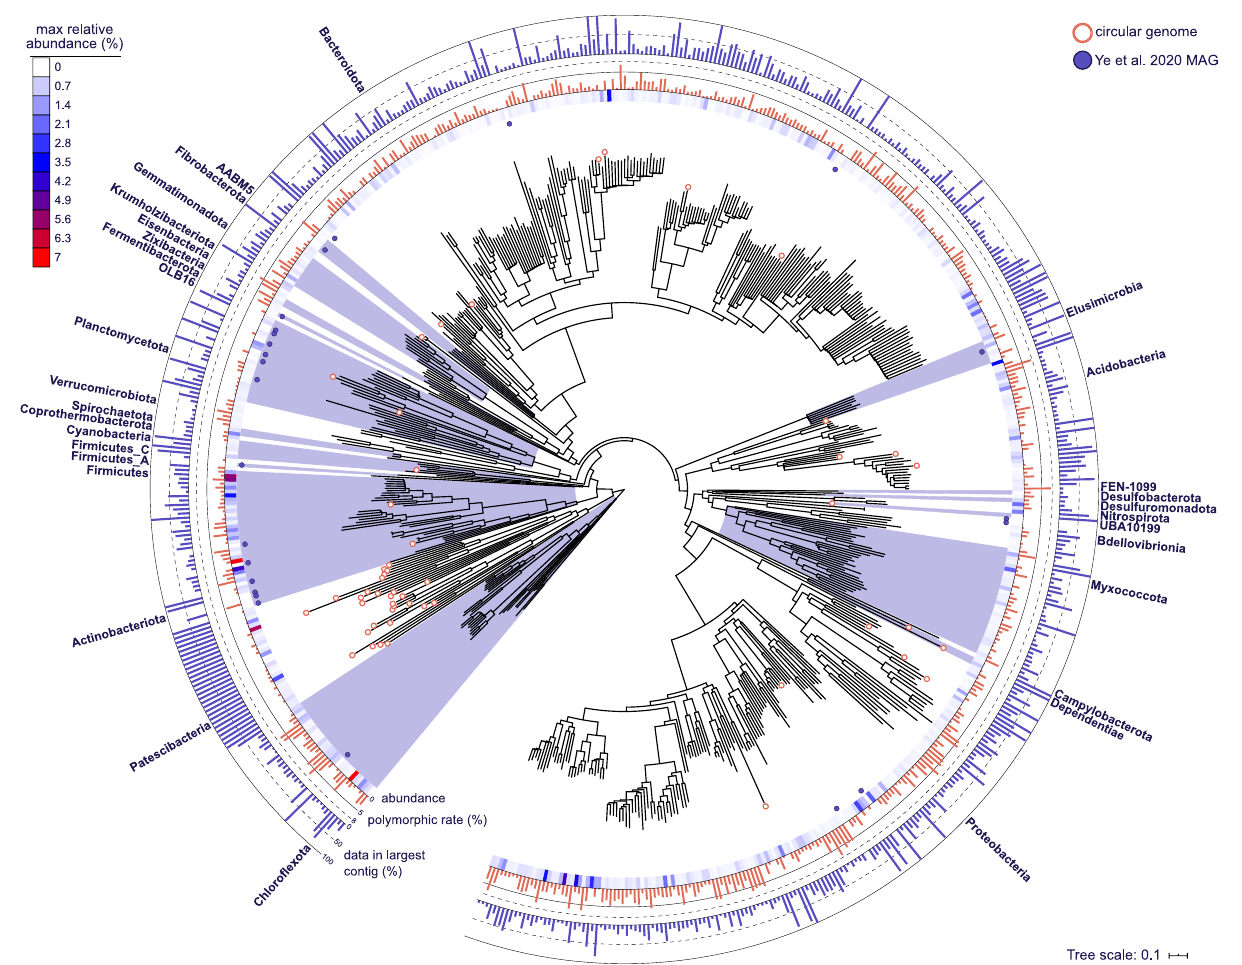
Fig. 2 Phylogenetic bacterial genome tree showing the diversity, maximum abundance, and contiguity of recovered species. The tree is based on the concatenated alignment of 120 single-copy marker gene proteins using GTDB-Tk. The 578 HQ bacterial species representatives are shown, with phyla labeled. Circular genomes are indicated at the tips using a white fi lled circle. HQ MAGs from Ye et al. 9 are indicated by the purple circles. The maximum relative abundance of the MAG across the 69 WWTP metagenomes is indicated by the heatmap. Polymorphic rate is indicated by the red bar chart and percentage of data incorporated in the longest contig within the MAG is indicated in the blue bar chart. Additional information on the MAGs is presented in Supplementary Data